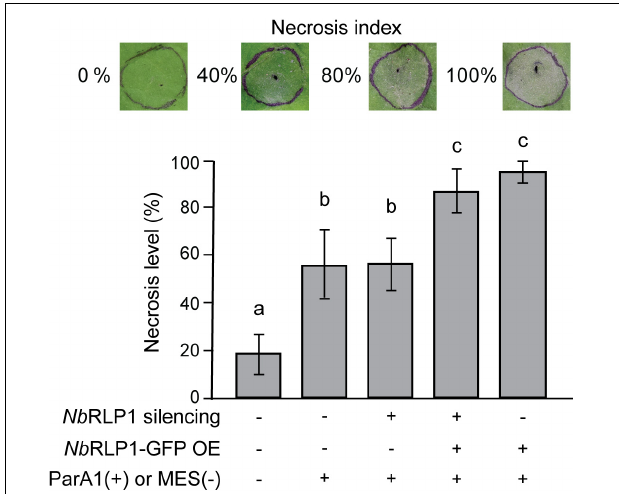
FIGURE 7 | Nb RLP1 overexpression exaggerated the ParA1-induced necrosis on Nicotiana benthamiana leaves. N. benthamiana leaves that are either silenced for Nb RLP1 expression or overexpressing Nb RLP1 are infiltrated with 0.3 µ M ParA1 or 10 mM MES (control) as indicated. After 24 h, the development of cell death was analyzed based on the representative necrosis index, defined by the percentage of necrosis area over the infiltrated area. The experiment has been repeated four times with similar results, and only one set of the experimental result is shown. Values are means ( ± SD) of 18 biological repeats. Different letters indicate significant differences based on LSD ( p <